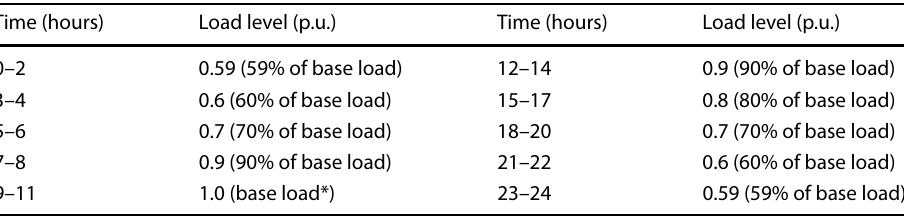
Table 14 Time-varying loading considered